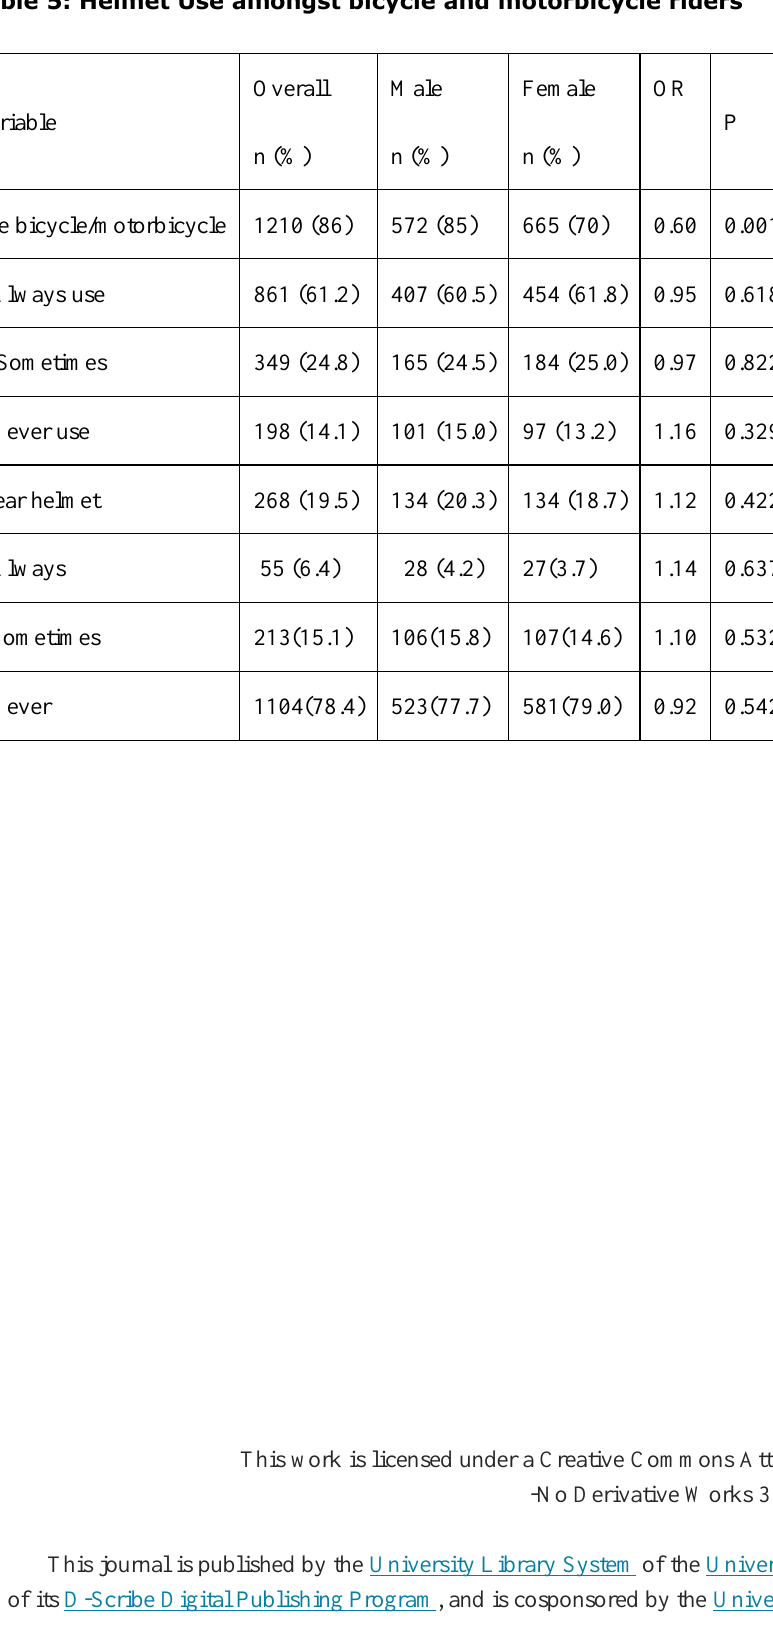
Table 5: Helmet Use amongst bicycle and motorbicycle riders